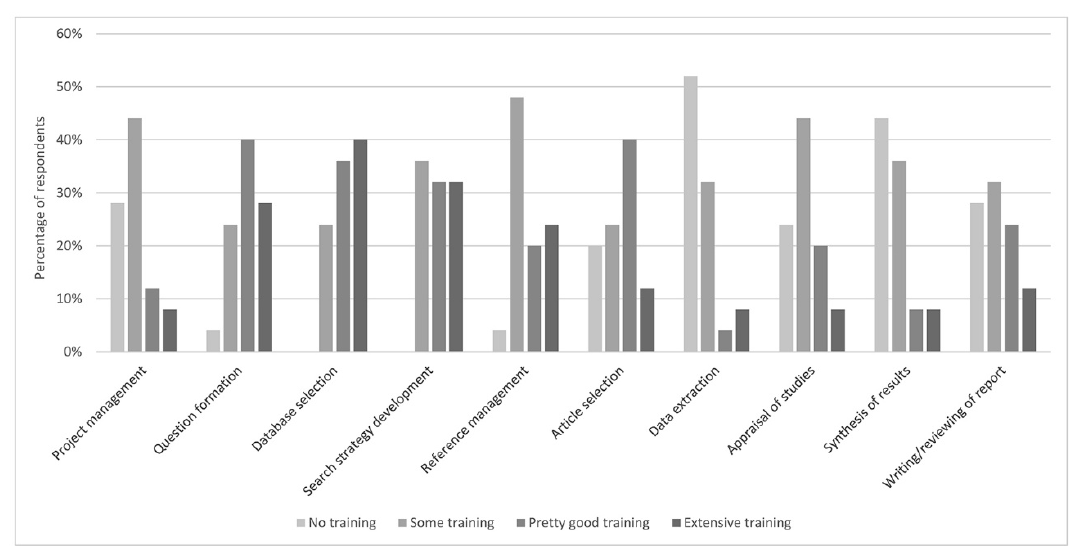
Figure 3 Training levels of veterinary